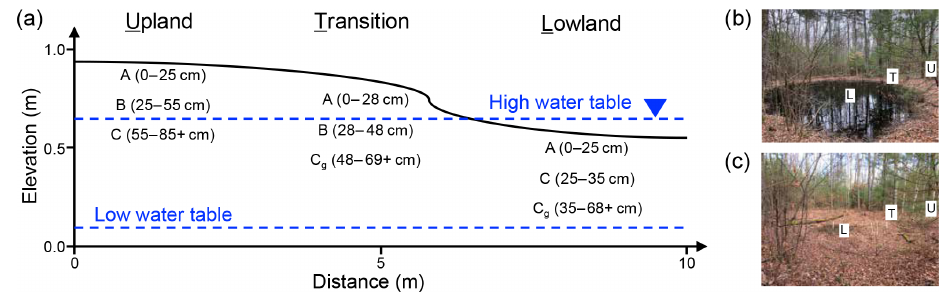
Figure 1. Illustration of upland–lowland transects in forested seasonally flooded mineral soils used for this study. (a) Approximate distances and elevation change between landscape positions along the transects as well as the horizons sampled within each position. Approximate seasonal high and low water table depths are indicated by dashed lines. Example of (b) flooded and (c) drained seasonal wetland with marked upland (U), transition (T), and lowland (L)